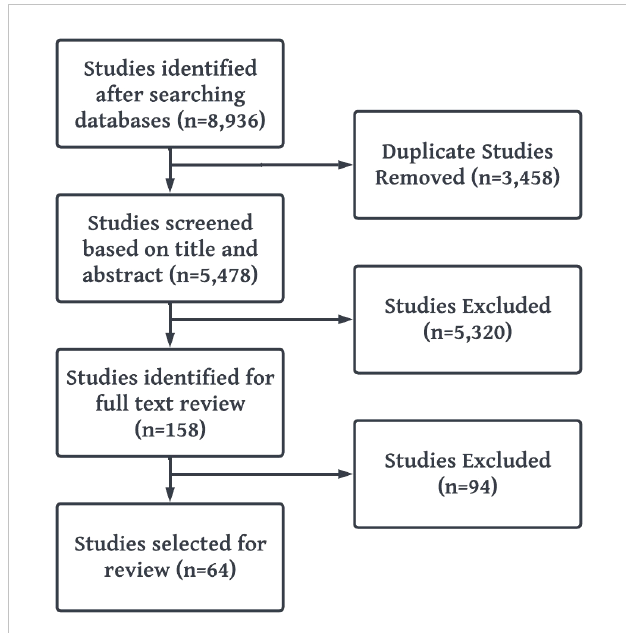
FIGURE 2 PRISMA fl ow diagram of study